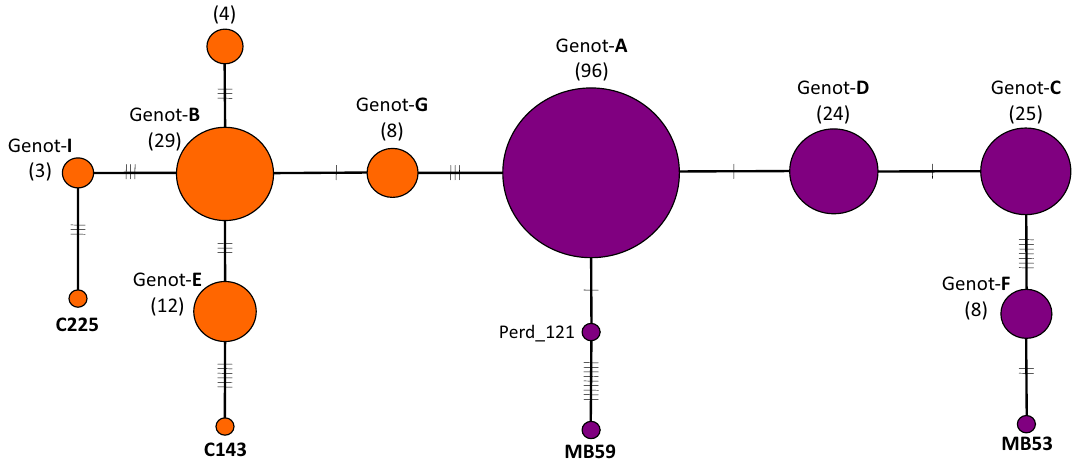
Figure 3. Intra-cultivar clonal genotypic diversity estimated with a custom-designed genotyping chip. A median-joining network was built with the genotypes using 41 SNVs loci obtained for 214 samples. Each circle represents a genotype and its size is proportional to the genotype frequency. We found 14 clonal genotypes, nine were represented by multiple samples (named from A to I) and five were singletons (C143, C225, MB53, MB59 and Perd_121). The hash marks crossing the connecting lines indicate the number of mutational steps differentiating genotypes. The color code represents groups Fr (orange) and Ar